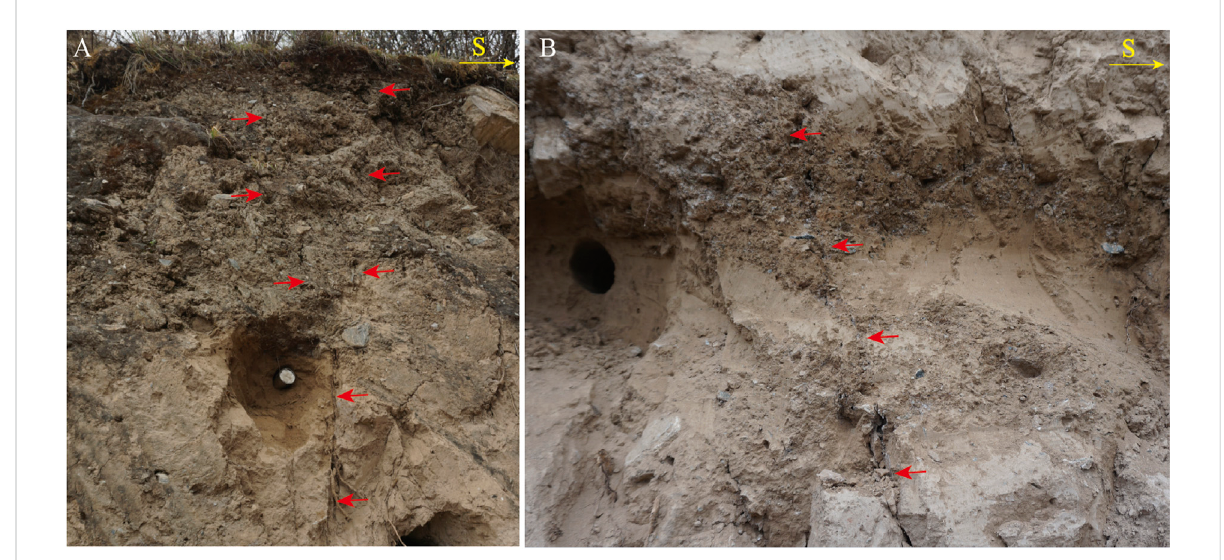
FIGURE 13 Photographs showing partial details of the Maisu fault. (A) and (B) close-up photographs of the areas de fi ned by the large and small white dashed rectangles, respectively, shown in Figure 12B.